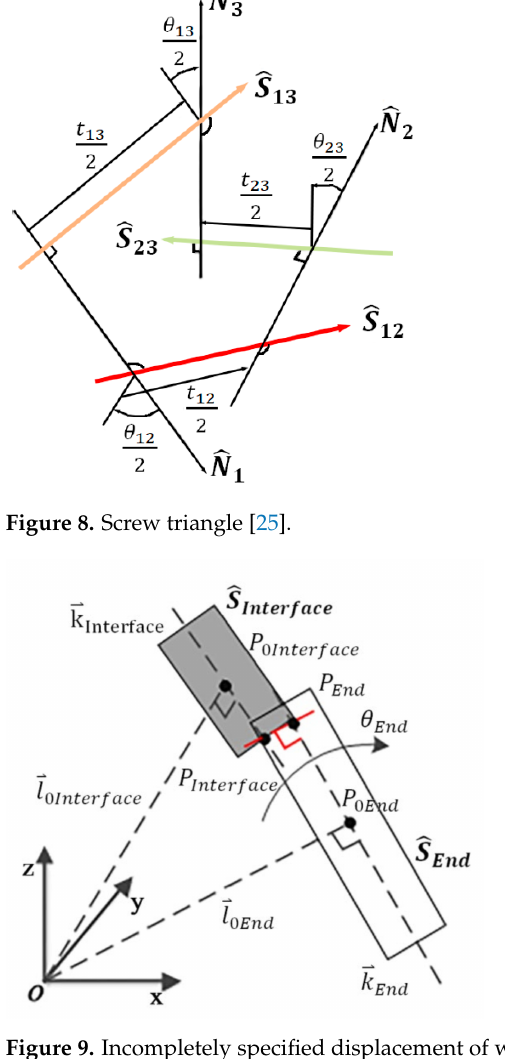
Figure 9. Incompletely specified displacement of welding axis alignment of pipe